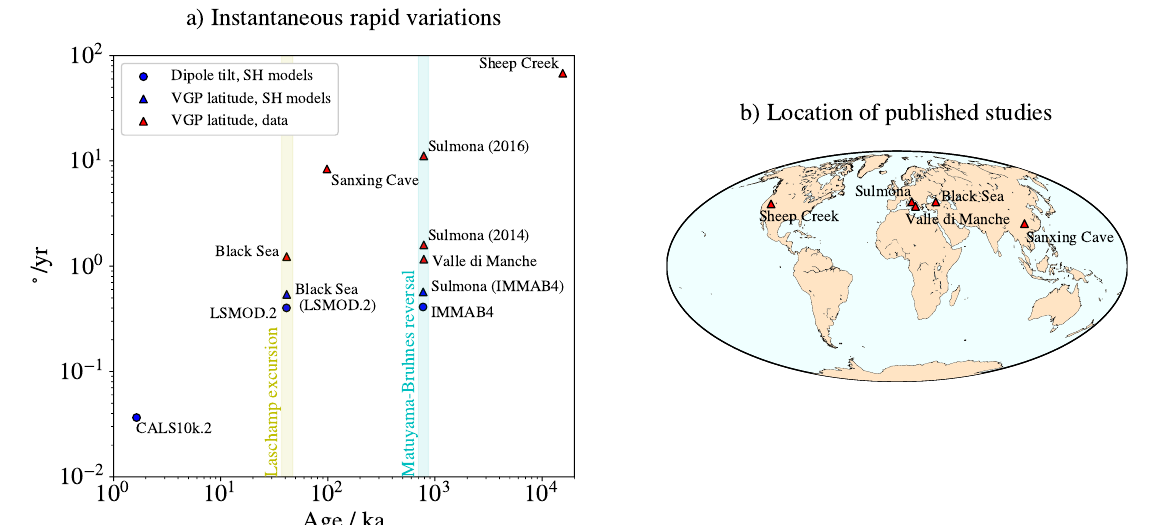
Figure 1. ( a ) Summary of rapid paleomagnetic variations from selected, published datasets (red symbols) and geomagnetic, spherical harmonics (SH) models (blue symbols). Circles and triangles indicate, respectively, maximum variations of dipole tilt and VGP latitude (see Section 2 for definitions), in degrees per year, over the timespan covered by the corresponding datasets or field models. Their location on the horizontal axis indicates the epoch at which the maximal variation was obtained (or reported). The sampling locations for the paleomagnetic datasets are reported in ( b ) and noted in both panels, and more information is available in relevant publications: Black Sea [18–20], Sanxing Cave [17], Sulmona Basin [13,14], Valle di Manche [16] and Sheep Creek [10]. The geomagnetic field models IMMAB4 [21], LSMOD.2 [22] and CALS10k.2 [11] have been sampled every 100 y for this